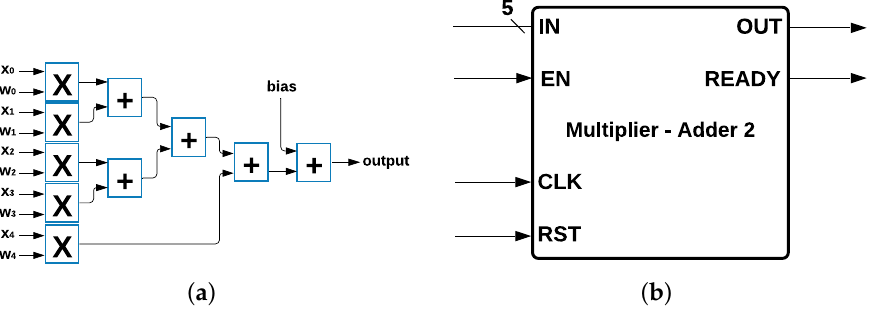
Figure 9. Multiplier Adder Module 1 and its Components: ( a ) Components of the Neurons of the Second and Third Layer; ( b ) Multiplier-Adder